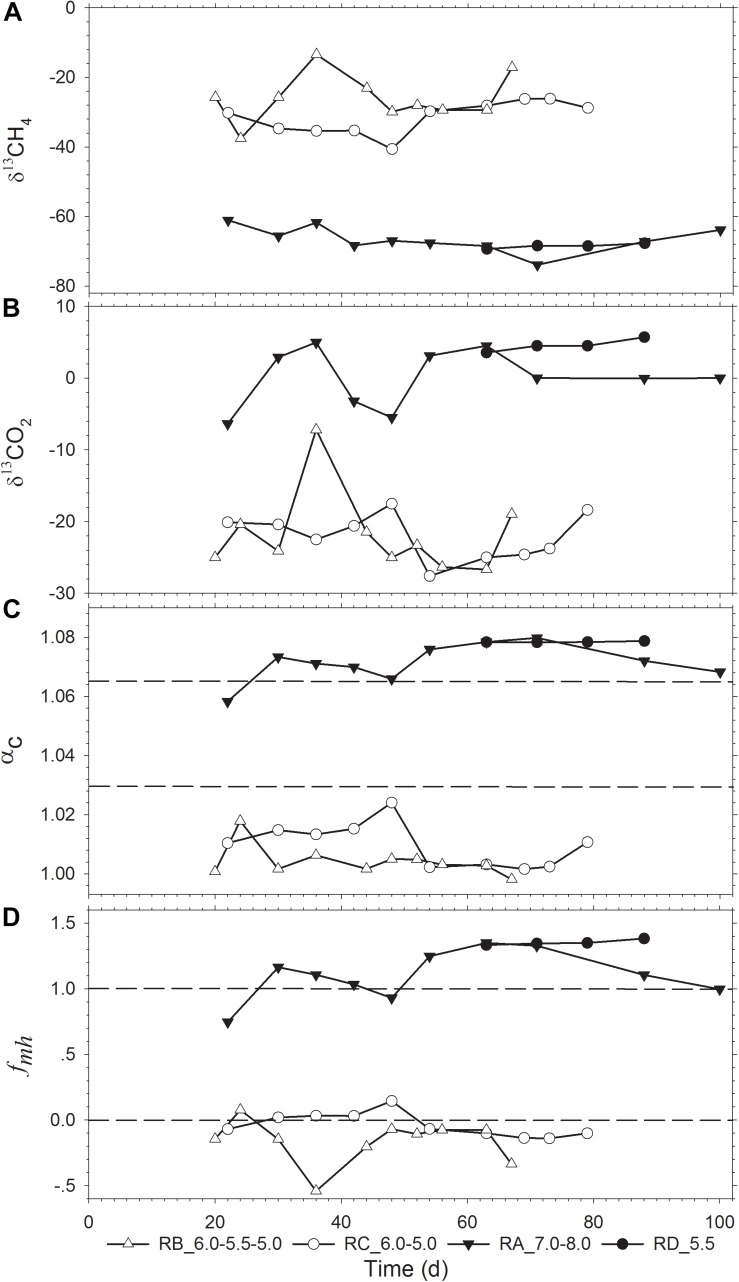
Temporal change of the stable isotopic indicators (A) δ13CH4 and (B) δ13CO2, and evaluation of (C) αc and (D)
fmh. δ13CH4 and δ13CO2 are the 13C isotope signatures of the produced CH4 and CO2; fmh is the fraction of CH4 produced through the hydrogenotrophic pathway (HM); αc is the apparent fractionation factor.